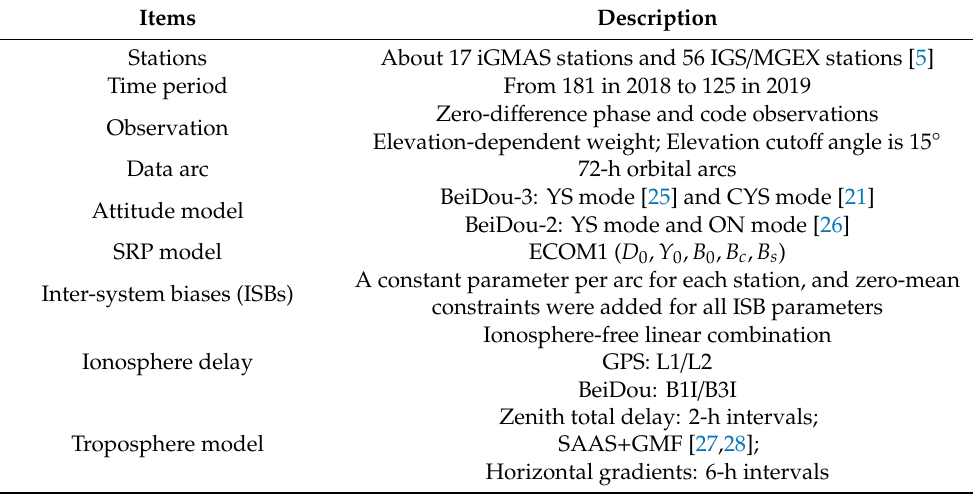
Table 1. Strategies for the precise orbit determination